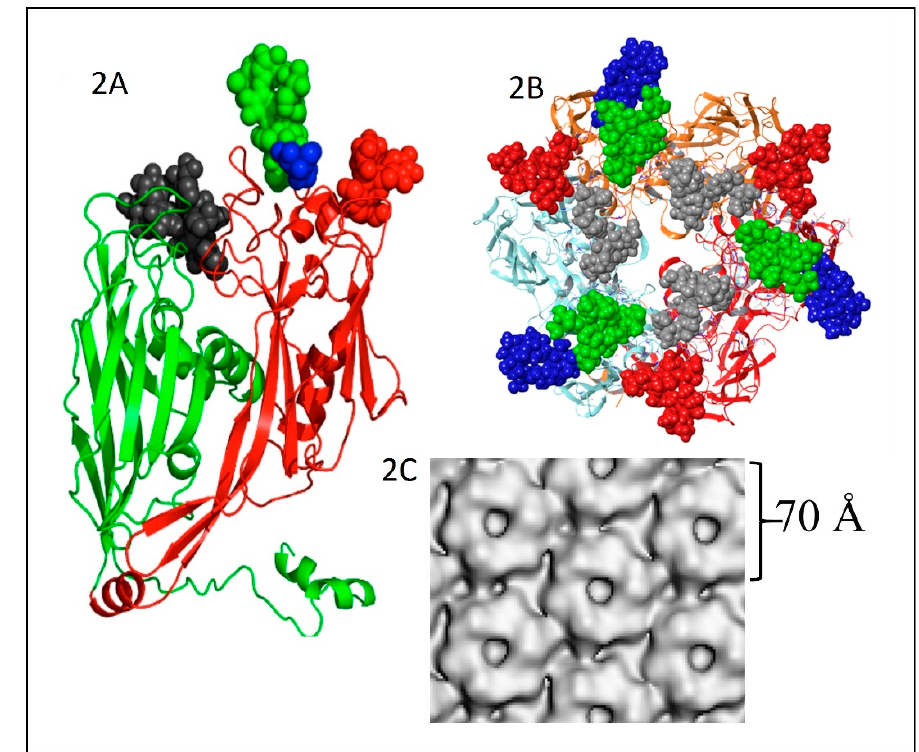
Figure 2. ( A ) Structure of a single PBCV-1 major capsid protein (Vp54). The four glycans attached to the major capsid protein at amino acids Asn 280 (green), Asn 302 (black), Asn 399 (red) and Asn 406 (blue) are on the outer surface of the virus. ( B ) Three of the major capsid proteins are assembled into a capsomer, viewed from the top. ( C ) Cryo-EM close up view of some capsomers. ( A , B ) are from De Castro et al. [51] and ( C ) is from Yan et al. [52]. All are published with permission.